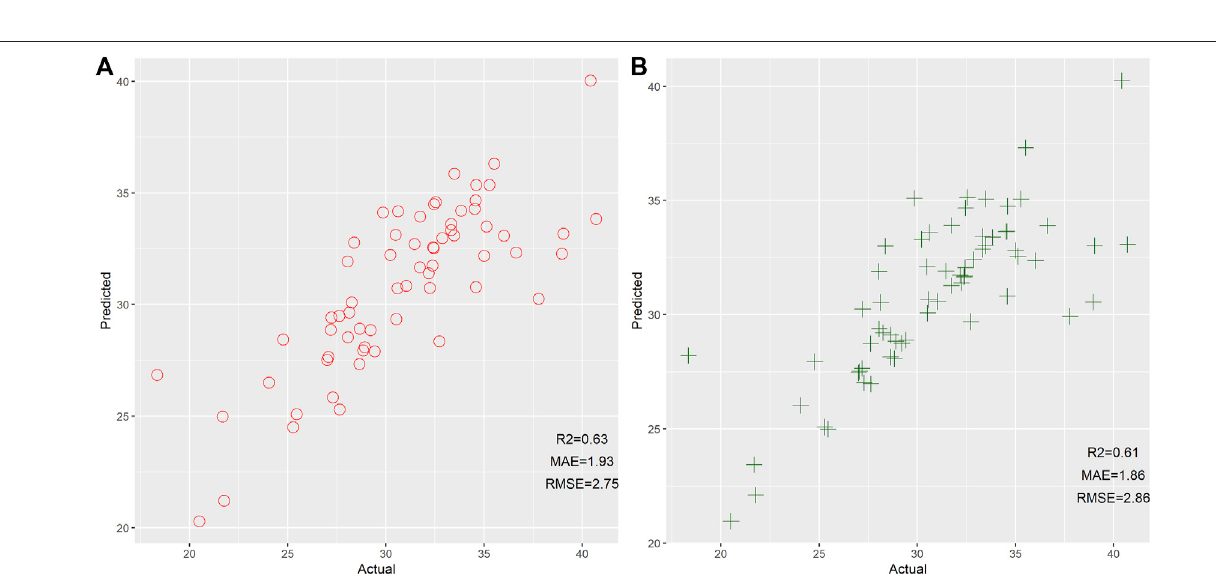
Frontiers in Genetics |